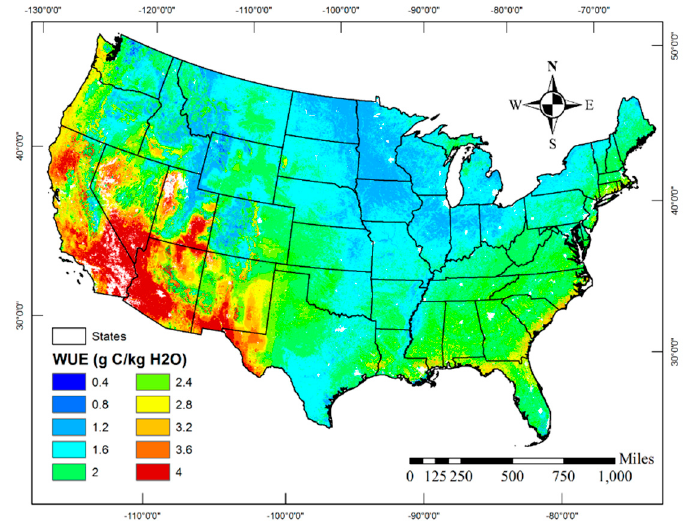
Figure 2. Spatial distribution of mean water use efficiency (WUE) over the contiguous US (CONUS) for the study period (2000–2014).